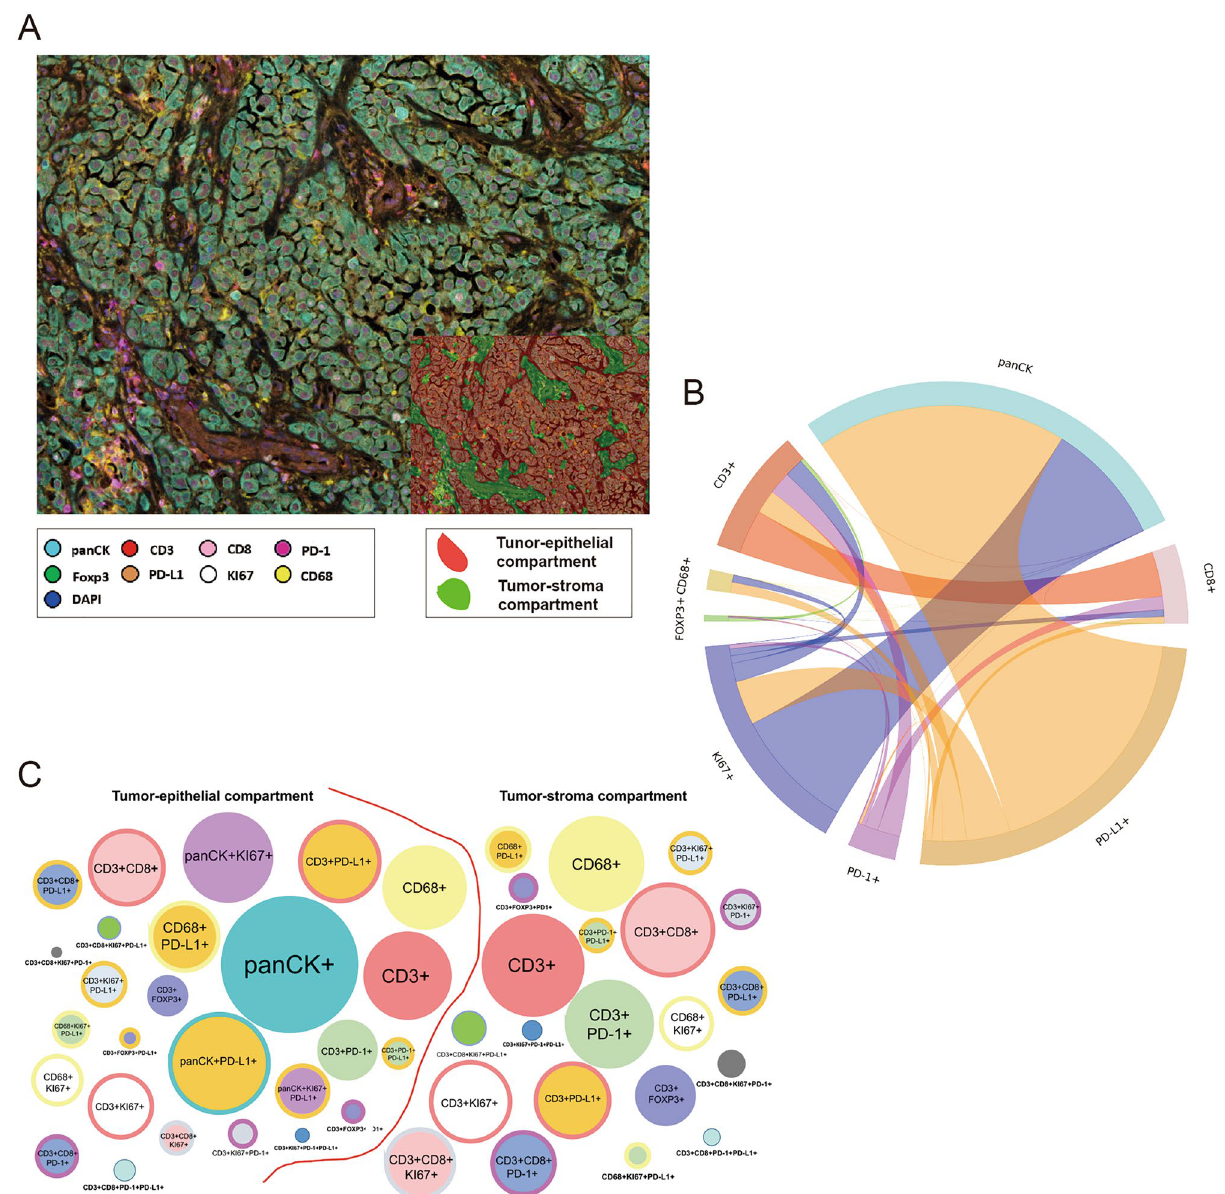
Figure 1. Representative microphotograph of multiplex immunofluorescence (mIF), graphic of markers’ co-expression and graphical representation comparing phenotypes between tumor-epithelial and tumor- stroma compartment in malignant pleural mesothelioma (MPM). ( A ) mIF image, inside, detail of compartmentalization of the tumor in tumor-epithelial ( red ) and tumor stroma ( green ) compartments. ( B ) Cord plot graphic showing the co-expression of the markers to generate the different cells phenotypes in the MPM cases. ( C ) Graphic representation of the relative densities of the different cell phenotypes in the tumor-epithelial and tumor-stroma compartments, as observed in the MPM cohort. Overall, the numbers of various immune cell phenotypes are higher in the tumor-stroma than in the tumor-epithelial compartment. mIF, 20 × magnification. The images were generated using Vectra/Polaris 3.0.3 scanner system, InForm 2.4.8 image analysis software (Akoya Biosciences), and R studio software version